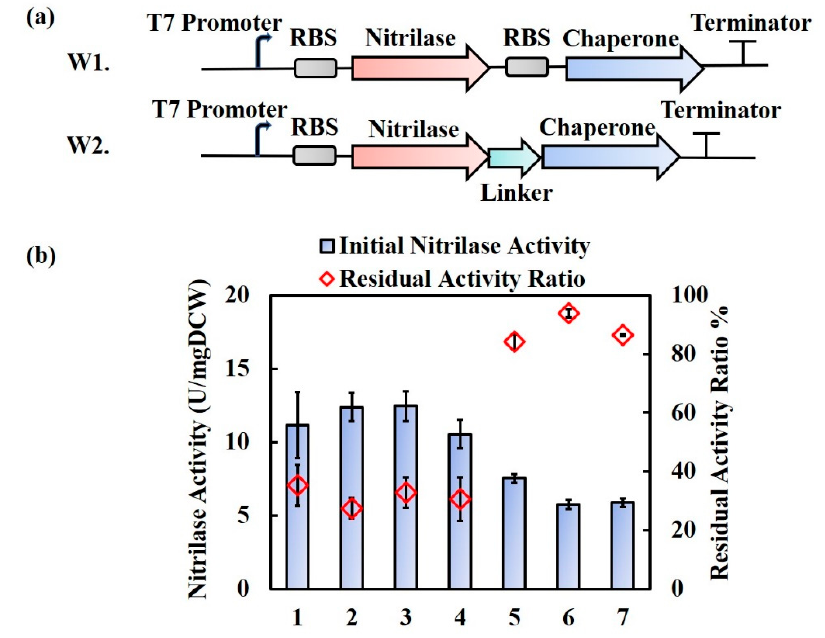
Figure 1. Co-expression and fusion-expression strategies for nitrilase and the chaperones Rr GroES, Rr GroEL, and Rr GroEL2. ( a ) Genetic design for co-expression and fusion expression of nitrilase with chaperones; ( b ) Nitrilase activity and the residual activity ratio of nitrilase in E. coli BL21(DE3) recombinant strains. Lane 1 to lane 7: (pET28a- Rr Nit) (control), (pET28a- Rr Nit + Rr GroES), (pET28a- Rr Nit + Rr GroEL), (pET28a- Rr Nit + Rr GroEL2), (pET28a- Rr Nit-FxL1- Rr GroES), (pET28a- Rr Nit-FxL1- Rr GroEL), and (pET28a- Rr Nit-FxL1- Rr GroEL2), respectively. The residual activity was measured under 50 ◦ C heat shock for 30 min. Residual activity ratio = Residual nitrilase activity / Initial nitrilase activity.